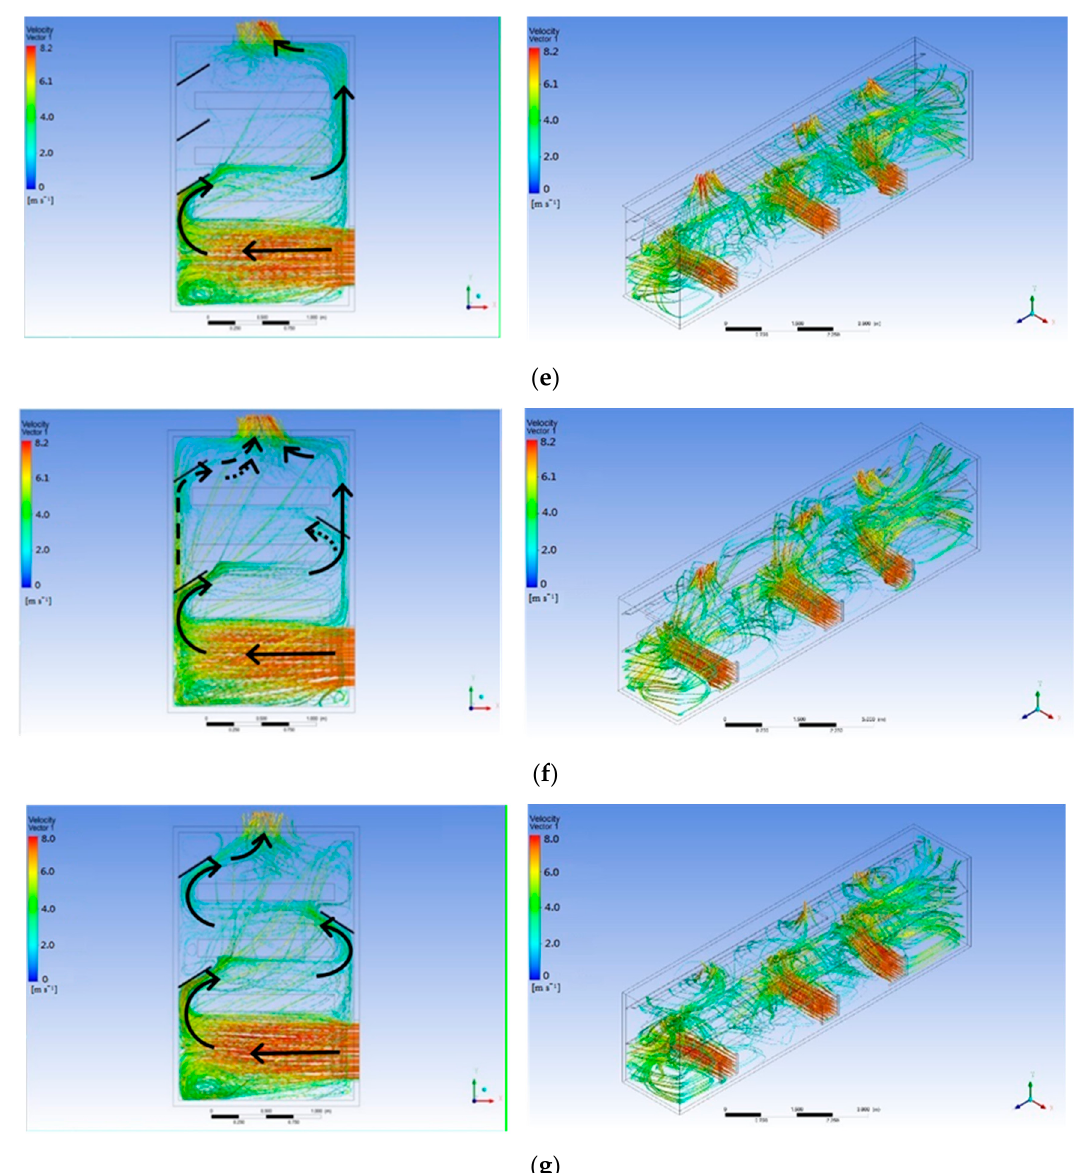
Figure 4. Airflow distributions inside the drying chamber with different deflector designs. ( a ) side view and front view of airflows in the drying chamber with type I deflector design. ( b ) side view and front view of airflows in the drying chamber with type II deflector design. ( c ) side view and front view of airflows in the drying chamber with type III deflector design. ( d ) side view and front view of airflows in the drying chamber with type IV deflector design. ( e ) side view and front view of airflows in the drying chamber with type V deflector design. ( f ) side view and front view of airflows in the drying chamber with type VI deflector design. ( g ) side view and front view of airflows in the drying chamber with type VII deflector design.